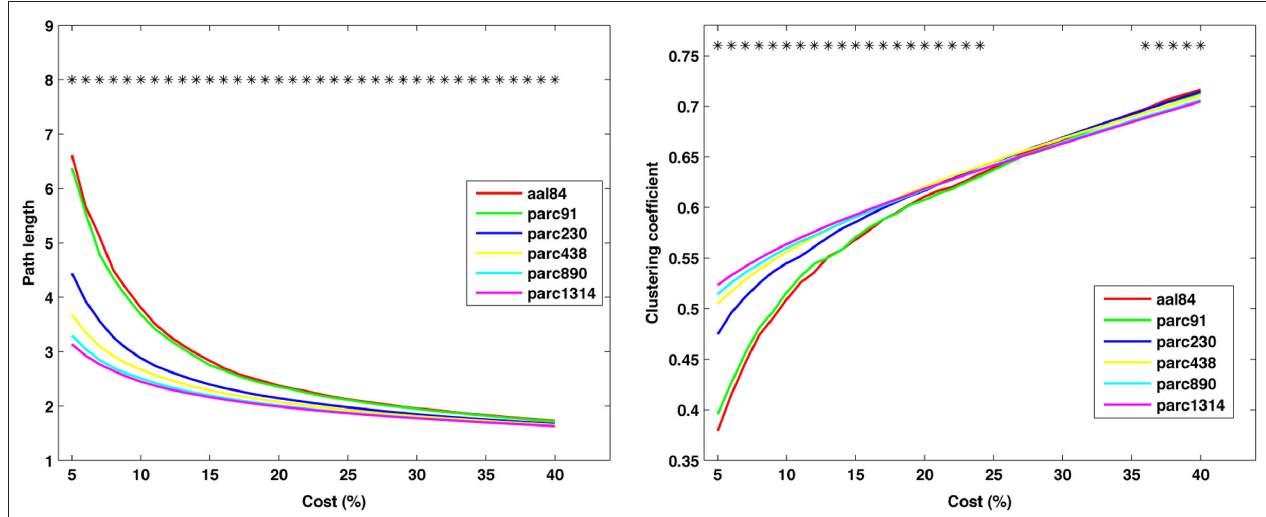
FIguRe 5 | Mean values of global network path length (left) and clustering coefficient (right) at each cost. * p < 0.05.